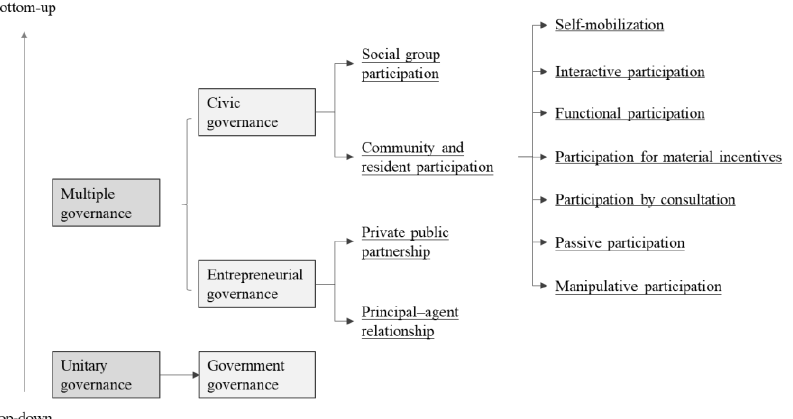
Figure 5. The categories of URG modes.